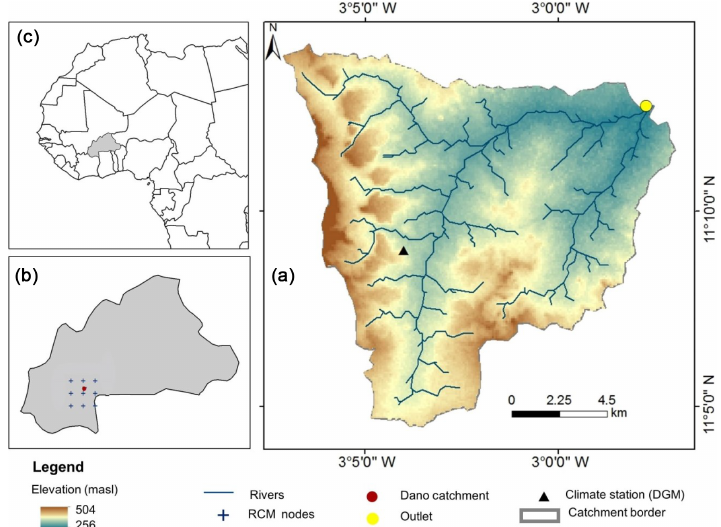
Figure 1. Location map: (a) Dano catchment, (b) its location in Burkina Faso, and (c) in West Africa. (b) RCM domain used in the study.